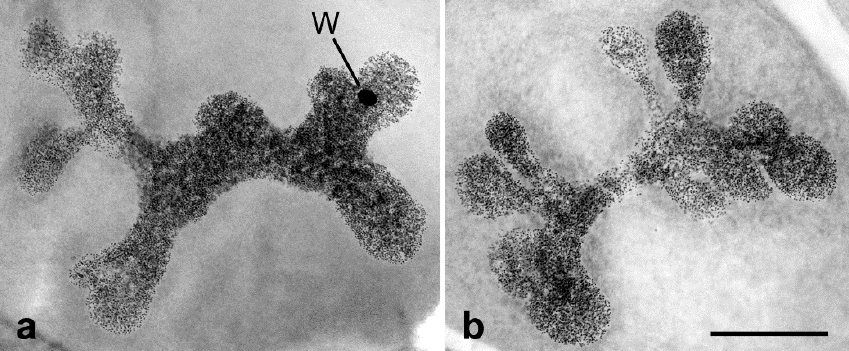
Figure 3. Highly polyploid nuclei of the Malpighian tubule cells from the carob moth, Ectomyelois ceratoniae Zeller, stained with lactic acetic orcein. ( a ) A nucleus from adult female showing a sex chromatin body (W). ( b ) A nucleus from male larva without sex chromatin. Bar = 50 µm. Chromosomes in Lepidoptera are usually small, numerous, and uniform in shape (Figure 1b).